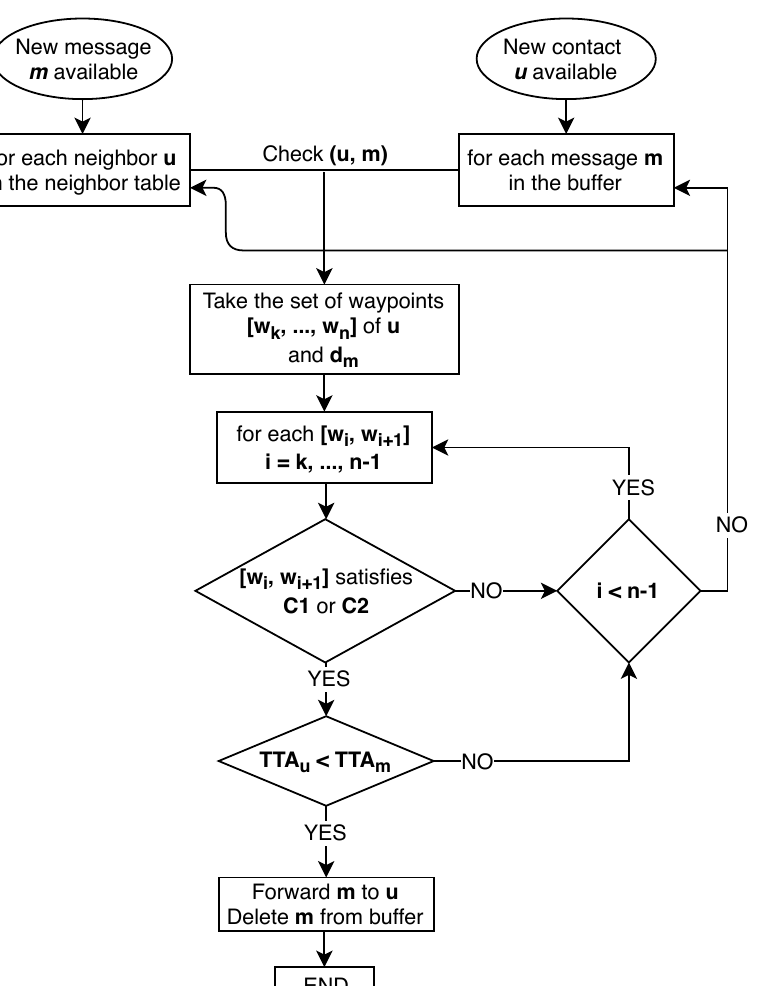
Figure 2. A flow chart illustration of the forwarding process of